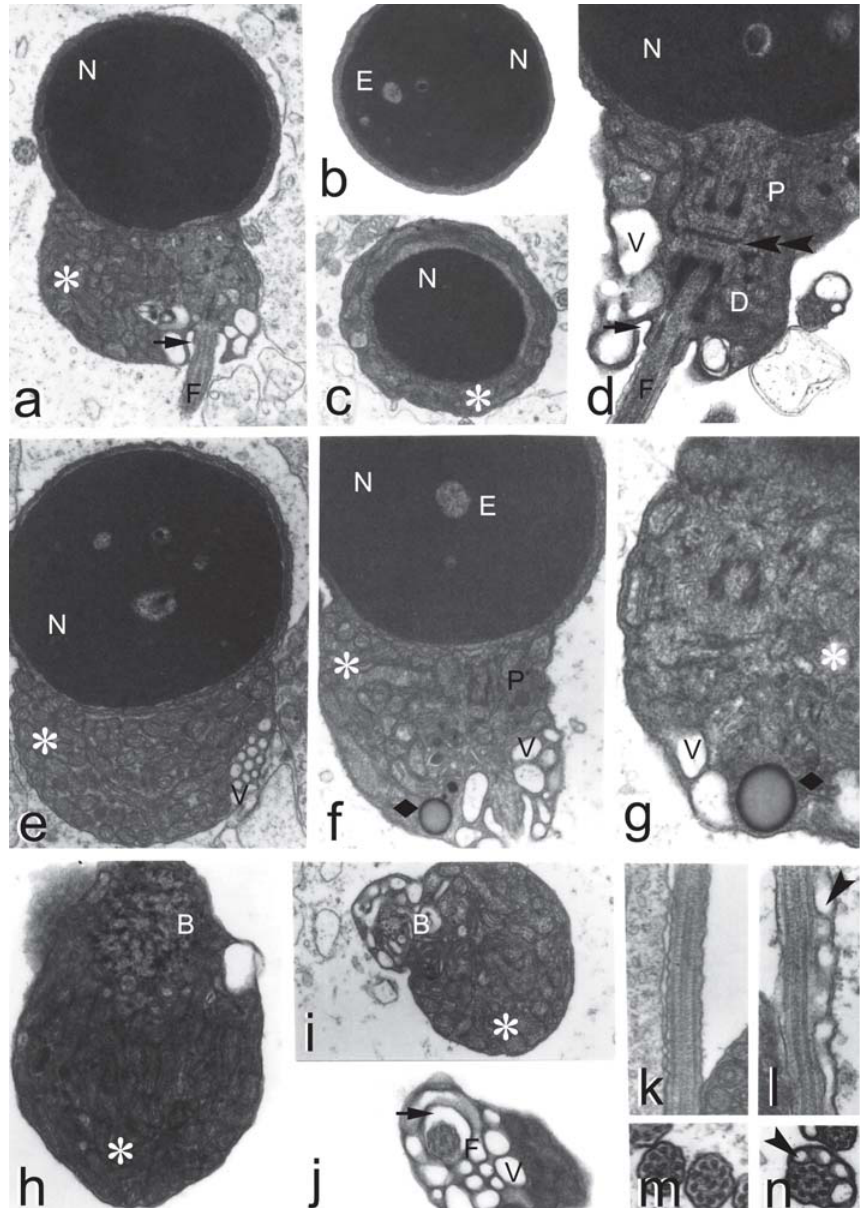
Fig. 3. Spermatozoa of Corydoras flaveolus . a ) Spermatozoon longitudinal section. b and c ) Nucleus in transverse sections. d ) Detail of centriolar arrangement. e to j ) Midpiece longitudinal and transverse sections showing mitochondria, vesicles, cytoplasmic channel, and electron-dense circular structure. k and l ) Flagellum longitudinal sections. m and n ) Flagellum cross sections. ( a ) X 17000; ( b, c ) X 15750; ( d ) X 28350; ( e, f, h ) X 23000; ( g, m ) X 42000; ( i ) X 18900; ( j ) X 25200; ( k ) X 25300; ( l, n ) X 31500. B: basal body; D: distal centriole; E: electron-dense structure; F: flagellum; N: nucleus; P: proximal centriole; V: vesicles; Asterisk: mitochondria, Arrow: cytoplasmic channel; Arrowhead: lateral membranous compartment; Double arrowhead: electron-dense material between the centrioles; Lozenge: electron-dense circular